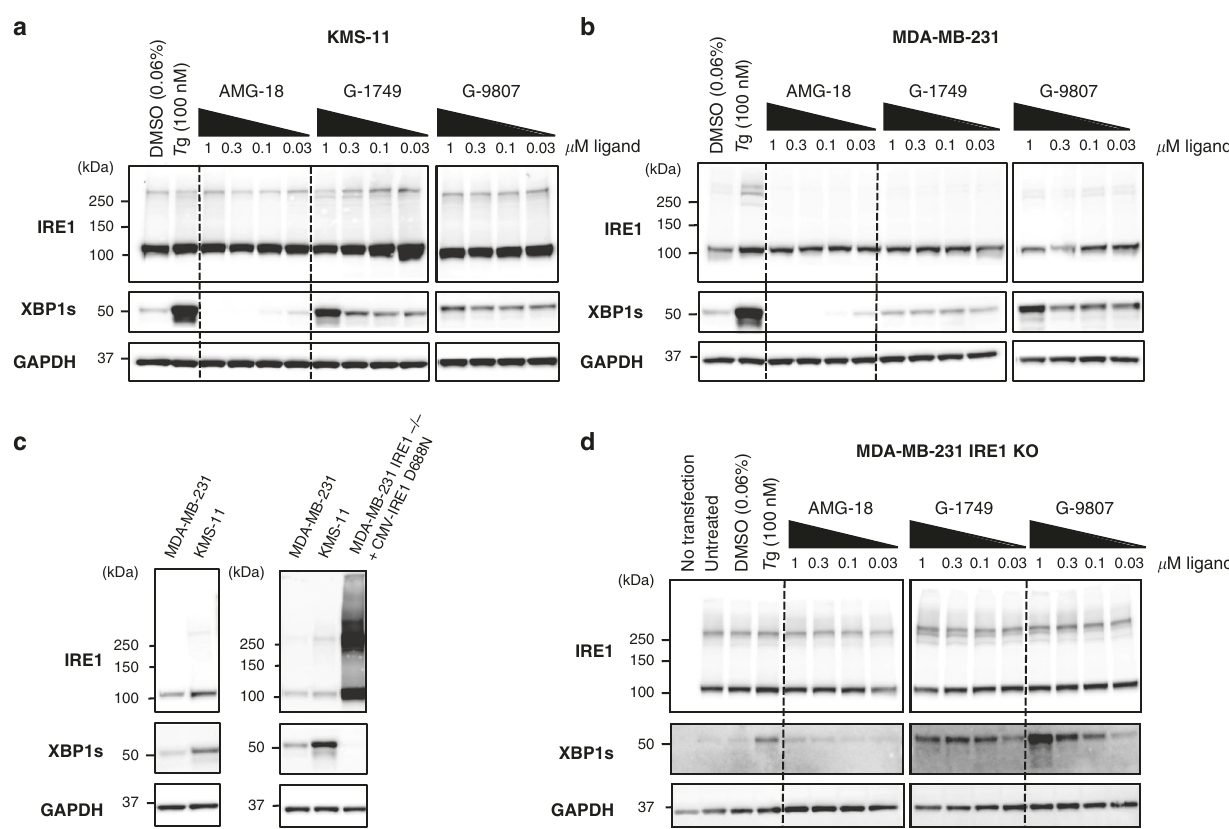
Fig. 6 G-1749 acts on pre-associated IRE1. a , b Western blots for indicated proteins of KMS-11 ( a ) and MDA-MB-231 ( b ) cell lysates after treatment of the cells for 4 h with indicated compounds. DMSO was used as a negative control (0.06%) and Thapsigargin (Tg, 100 nM) as a positive control. Before being loaded on a gel, lysates were crosslinked with disuccinimidyl suberate (DSS, 250nM) for 1 h at room temperature, quenched with TRIS buffer (1 M) for 15 min at room temperature. One representative out of two experiments is shown. c Comparison of IRE1 and XBP1s protein concentration in, left, KMS-11 and MDA-MB-231 cell lines, compared to, right, MDA-MB-231 IRE1 − / − after transfection with IRE1 kinase-dead (D688N) using a CMV promoter. d Kinase-dead (D688N IRE1) under the control of a CMV promoter was overexpressed in MDA-MB-231 IRE1 KO cells using a lipofectamine kit. Transfected cells were then treated with compounds for 4 h. Reported are western blots of indicated proteins after crosslinking with DSS. One representative out of two experiments is shown. Source data for all blots are provided as a Source Data fi